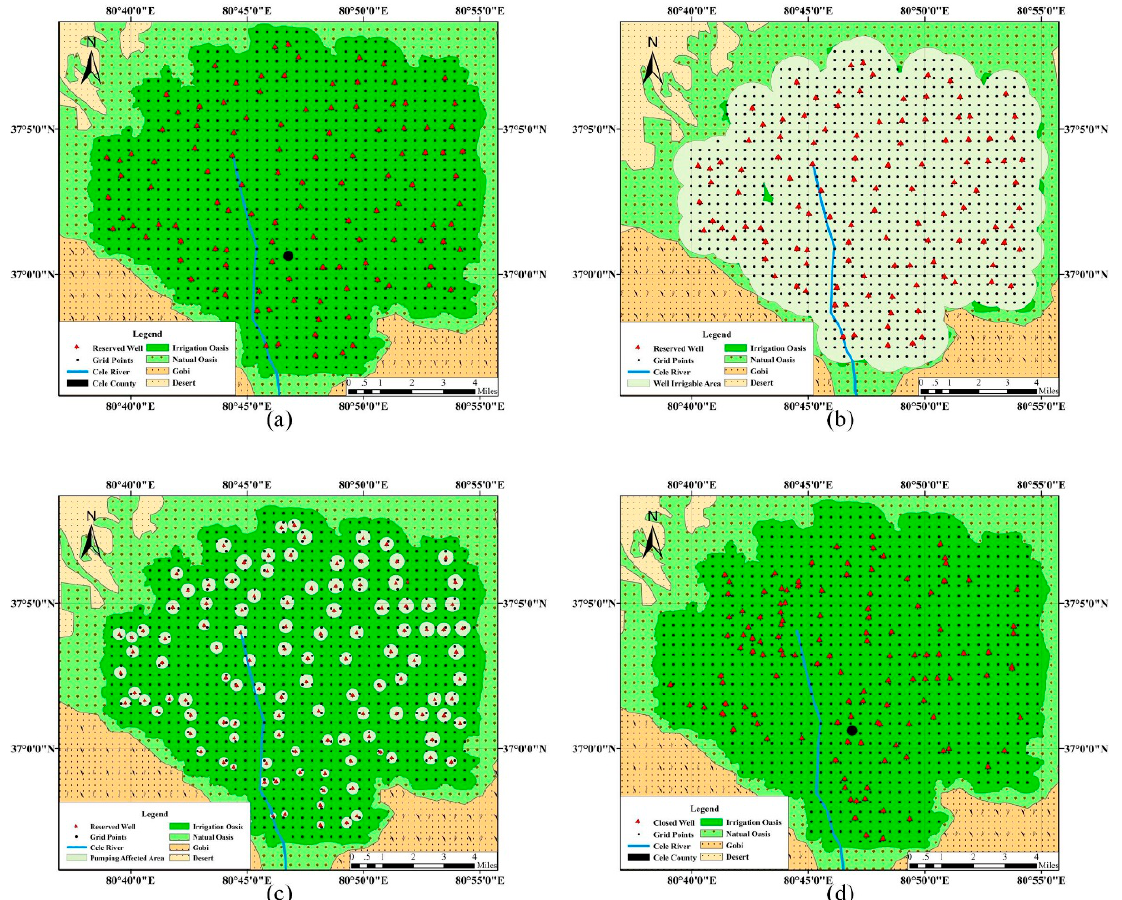
Figure 4. Well layouts of implicit cost optimization (ICO) in the Cele Oasis: ( a ) well optimization layout, ( b ) well optimization irrigation radius layout, ( c ) well optimization influence radius layout, and ( d ) recommended closed well layout.